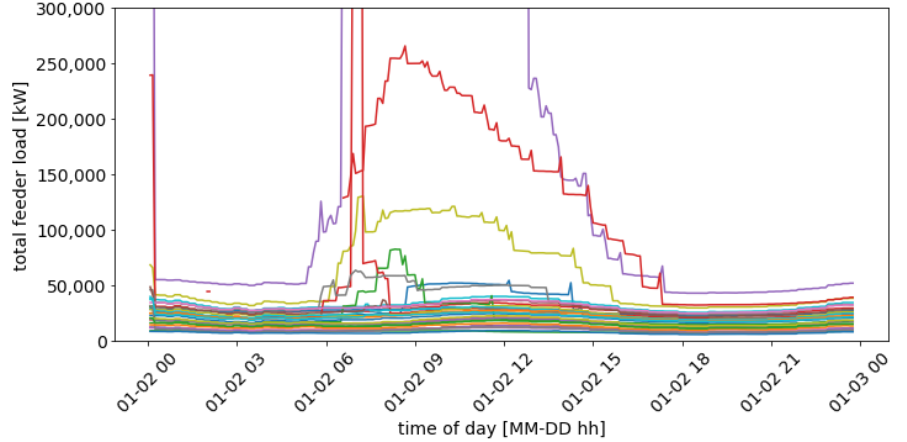
Figure 8. Scenario 2 feeder loads with EV charging rates zoomed-in to highlight lower load ranges.